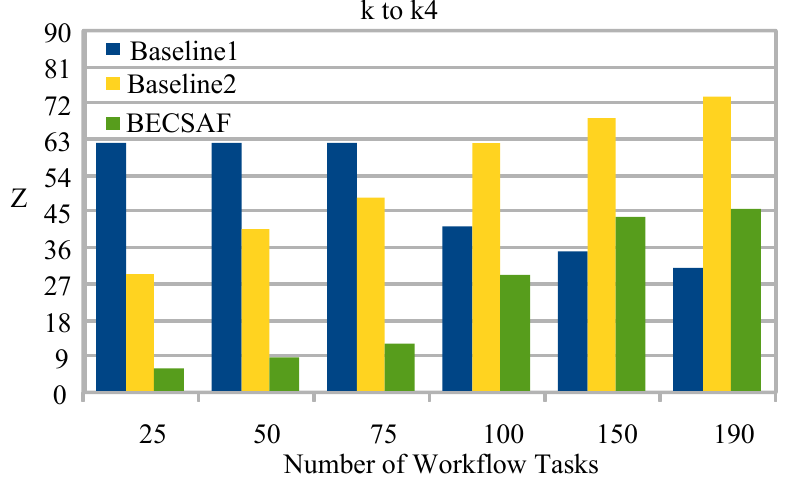
Figure 9. Cost of Failure Between Fog Node k 3 to k 4 During Data